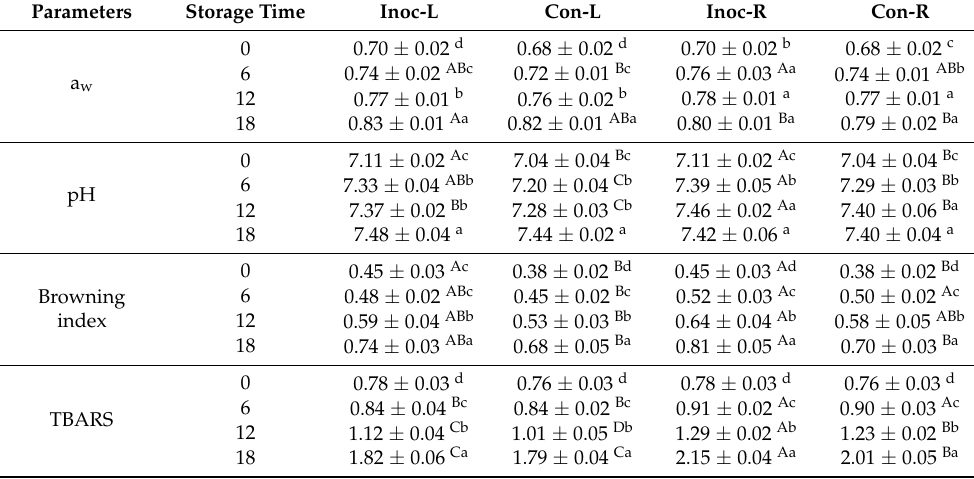
Table 1. Water activity (a w ), pH, browning index (A 420 ) and TBARS value of shrimp paste with/without B. subtilis K-C3 inoculation during 18 months of low (4 ◦ C) and room (28 ◦ C) tempera- ture